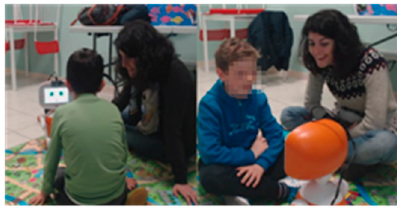
Figure 1. Two examples of robot and child interaction under the supervision of an